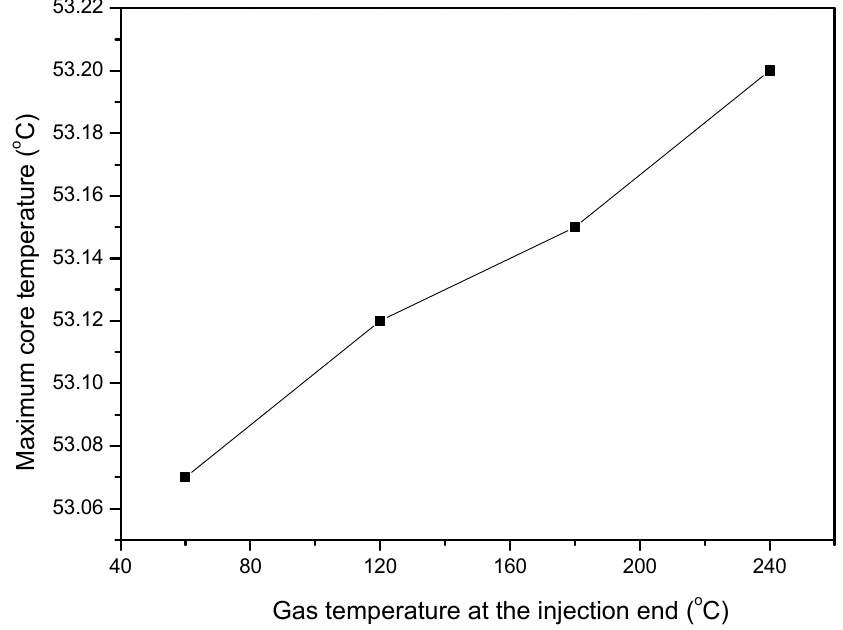
Figure 9. Maximum temperature in cores with different injection gas temperatures.